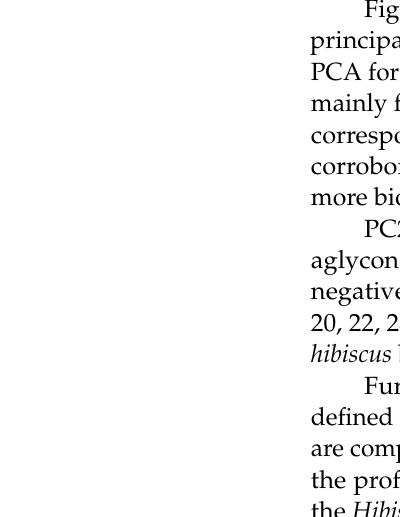
Values represent mean ± SD ( n = 3). Different lowercase letters in the same row indicate a significant difference ( p < 0.05) between beverages for each fraction. (<LOQ) = below the limit of quantification. n.d. = not detected. HB = Hibiscus